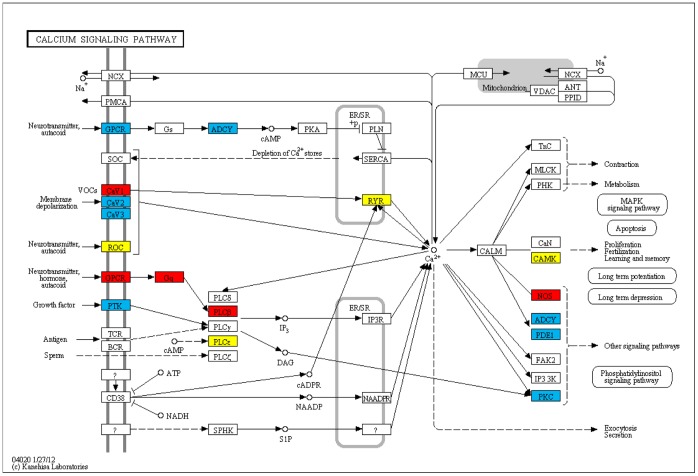
KEGG pathway for calcium signaling.The set of genes shown in blue includes genes that are found by EU GWAS; yellow includes genes that are found by JP GWAS; red includes genes that are found both by EU and JP GWAS.